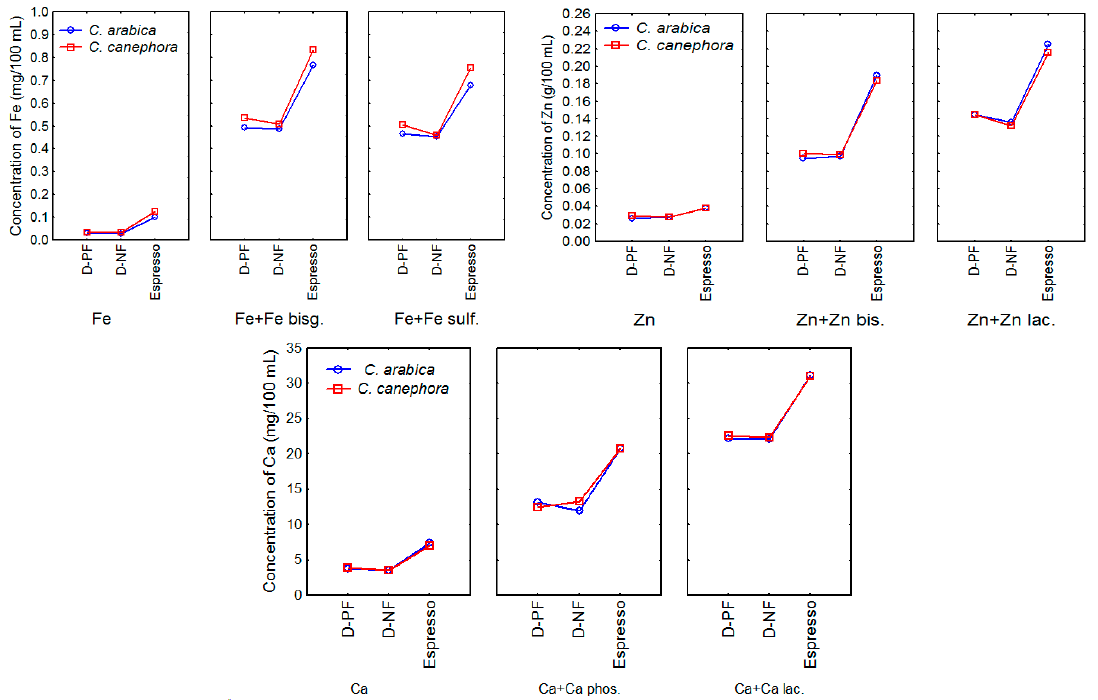
Figure 2. Means plot considering the influence of different coffee species, brewing methods (dripper paper filter (D-PF), dripper nylon paper (D-NF) and espresso), and minerals. Fe bis—ferrous bisglycinate chelate, Fe sulf—ferrous sulfate; Zn bis—zinc bisglycinate chelate; Zn lac—zinc lactate; Ca phos—tricalcium phosphate; Ca lac—calcium lactate.